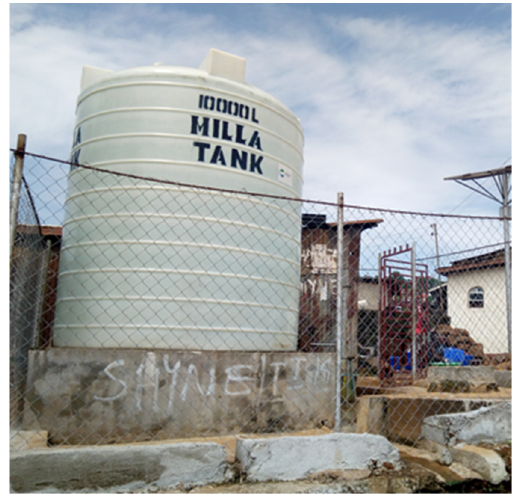
Figure 2. Water provided in 10,000 L tank at Allen Town.